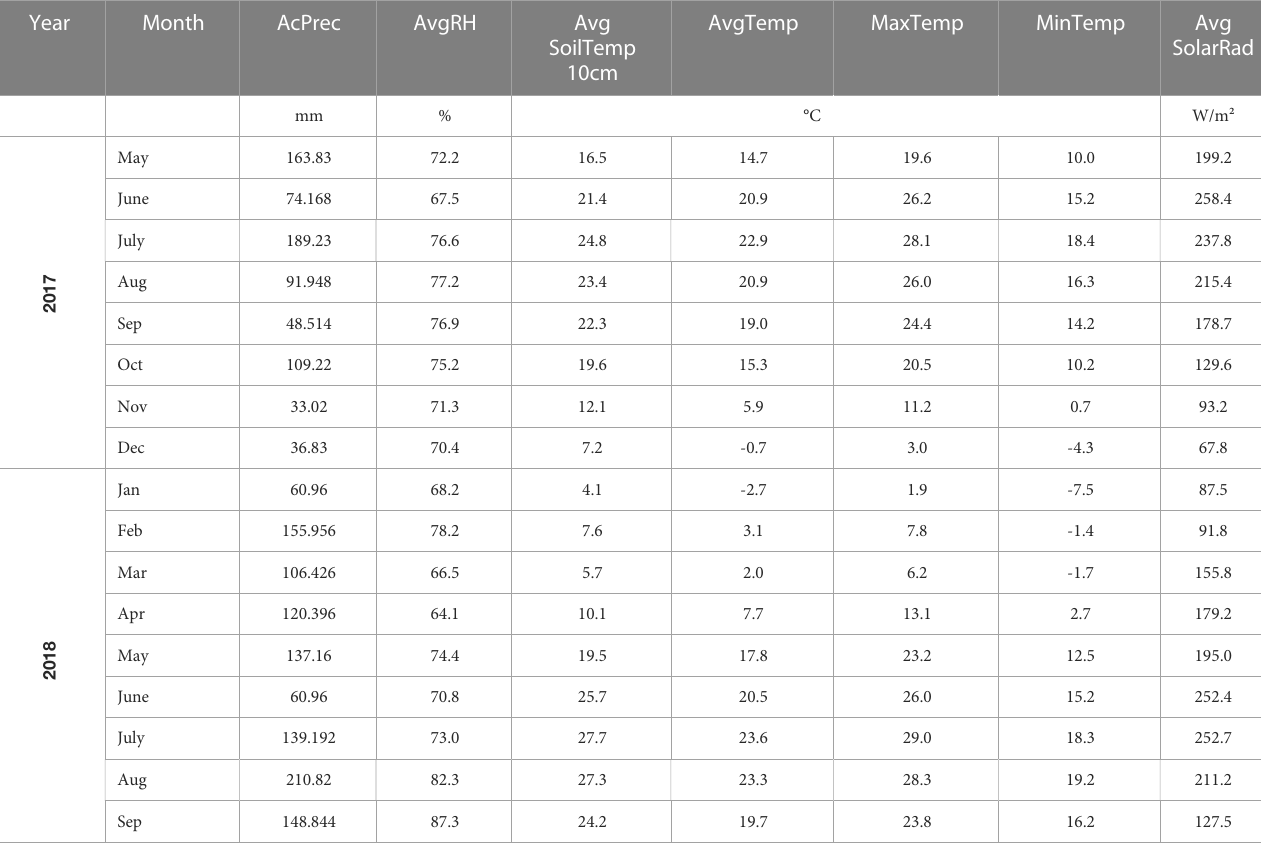
TABLE 1 Weather variables in Pittstown, NJ during the period of the